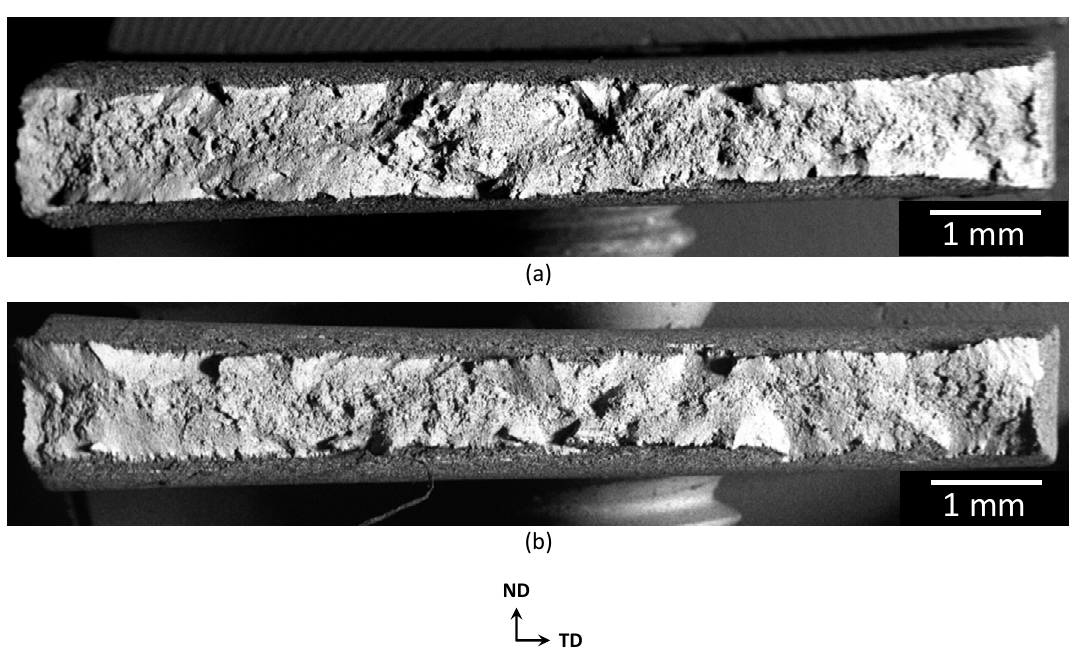
Figure 12. Overview secondary electron images of the fracture surface of NiCrMoV steel tested in 0.01 M acetic acid at 90 °C ( a ) without coating, ( b ) with FFA coating.